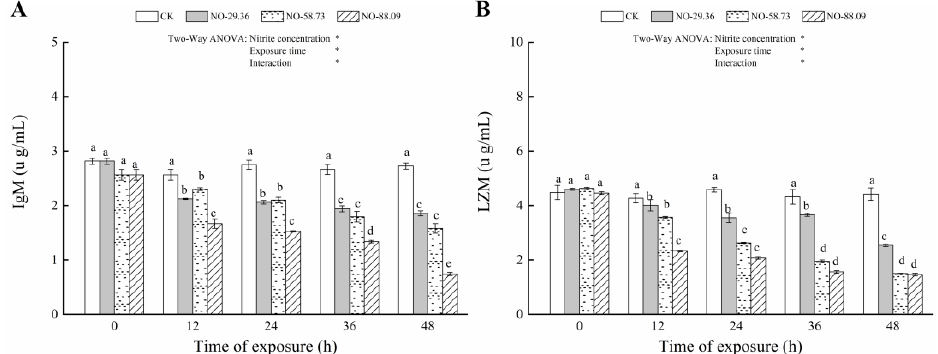
Figure 5. Changes in immunoglobulin (IgM) ( A ) and lysozyme (LZM) ( B ) levels in the serum of large yellow croaker exposed to nitrite at 29.36 mg/L (NO-29.36), 58.73 mg/L (NO-58.73), 88.09 mg/L (NO-88.09), and 0 mg/L (CK) for 48 h. Values are expressed as the mean ± SD. Different lowercase letters indicate significant differences ( p < 0.05) among groups. The CK nitrite group served as the control. * p < 0.05.